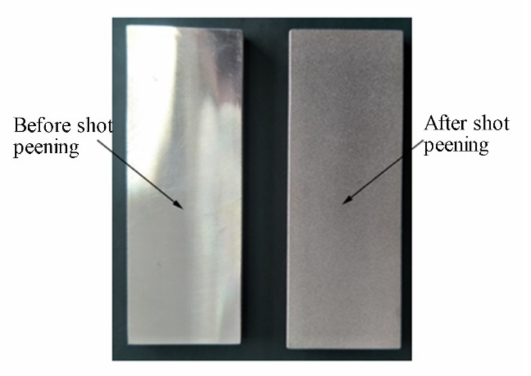
Figure 8. Sample before and after